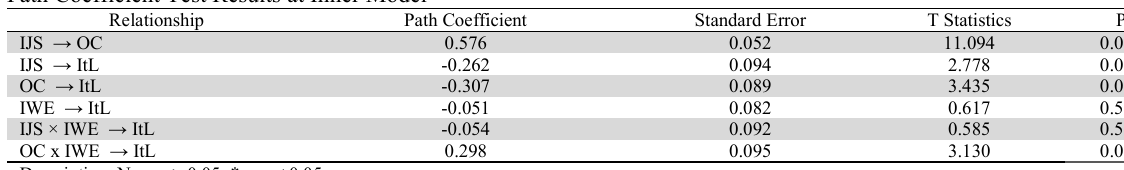
Path Coefficient Test Results at Inner Model